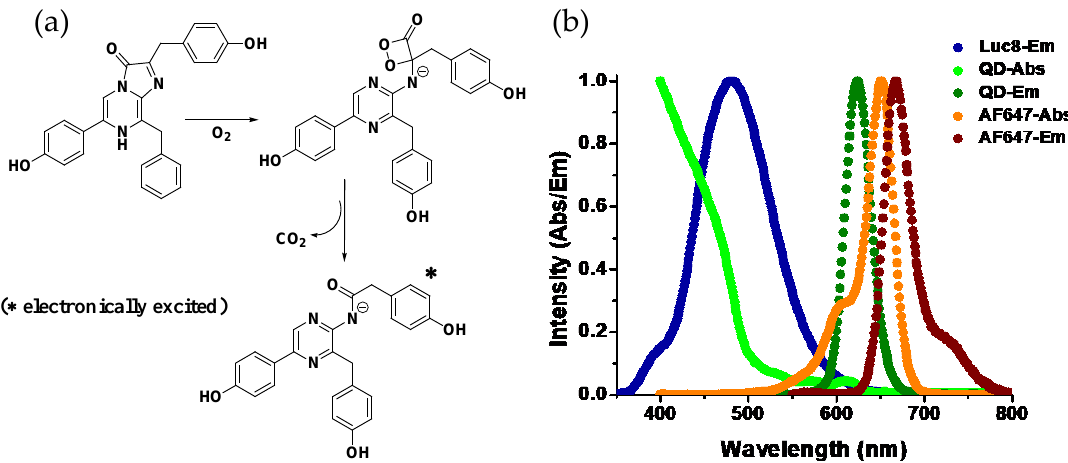
Figure 1. ( a ) Reaction mechanism of Renilla luciferase: catalyzed oxidation of coelenterazine to coelenteramide involving a typical strained four-membered cyclic peroxide intermediate with high energy content. The decomposition of the peroxide is exothermic resulting in electronic excitation of the product with the ability to emit light upon relaxation. ( b ) Plots displaying the normalized emission spectrum of Luc and both absorption and emission profiles of quantum dots (QD)-655 and the organic dye Alexa Fluor-647. While both the QD and the AF647 emit in a similar spectral range, due to the broad absorption spectrum of the QD and therefore large spectral overlap with the emission spectrum of Luc, energy transfer is far more favorable to the QD than to the dye. This is facilitated by the QD’s extinction coe ffi cient of ~7,500,000 M − 1 cm − 1 at 450 nm as compared to that of AF647 (260,000 M − 1 cm − 1 at 647 nm) along with their respective quantum yields of 50% and 33%, respectively.